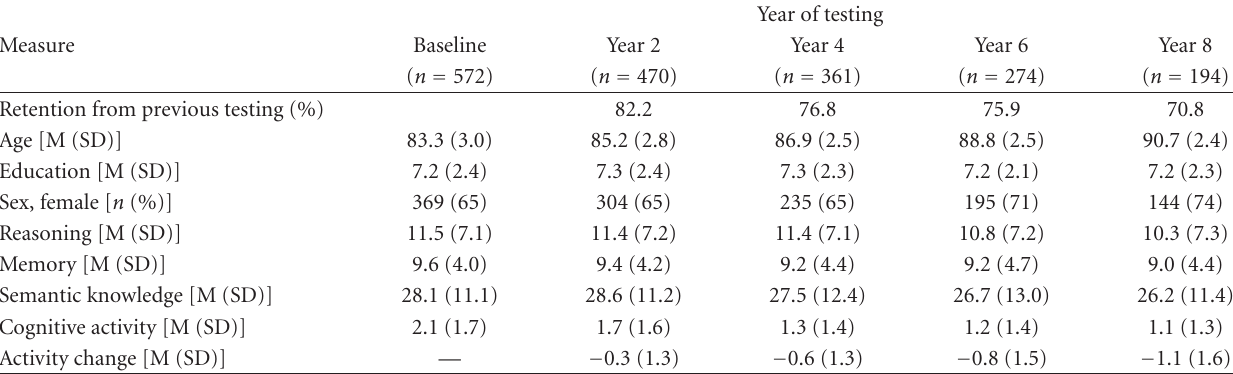
Table 1: Octo-Twin participant characteristics.